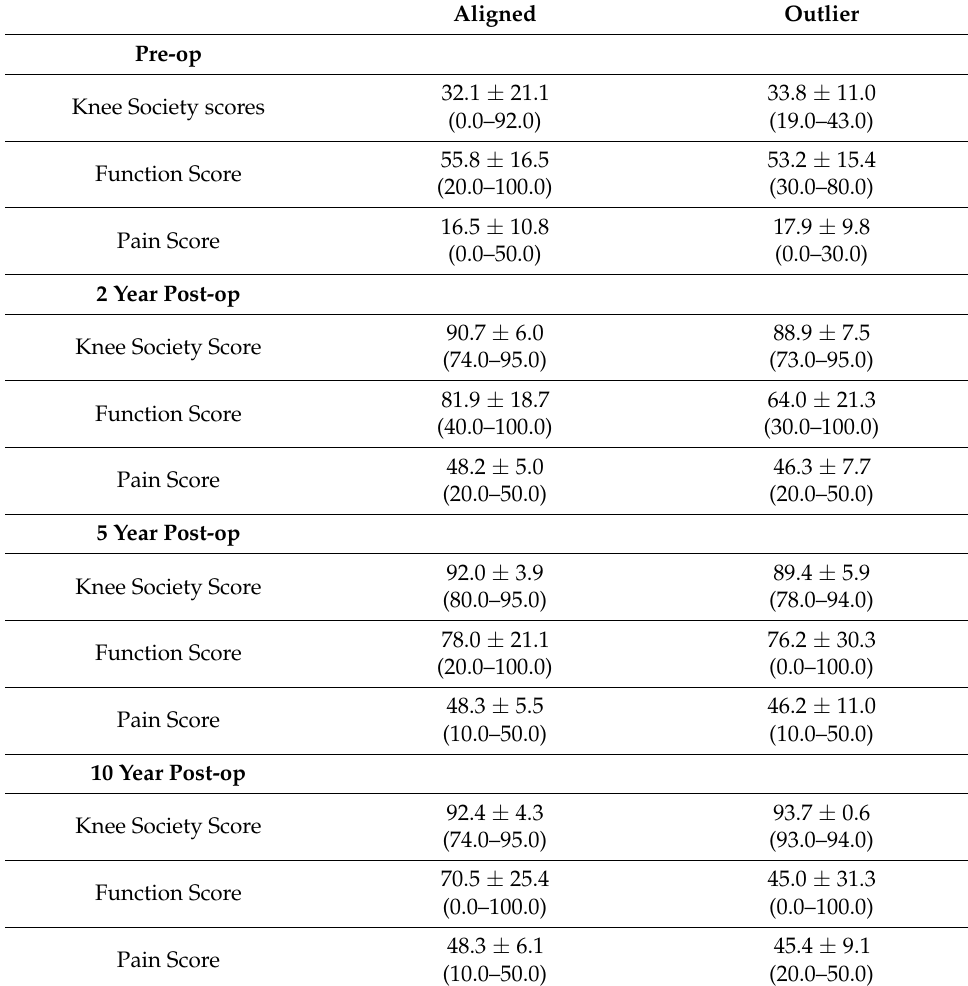
Table 2. Mean, standard deviation and range of clinical